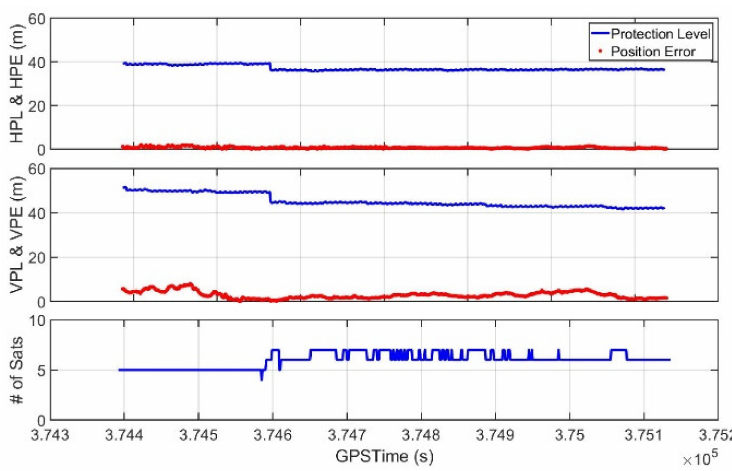
Figure 17. Position error and protection levels of the operating drone.